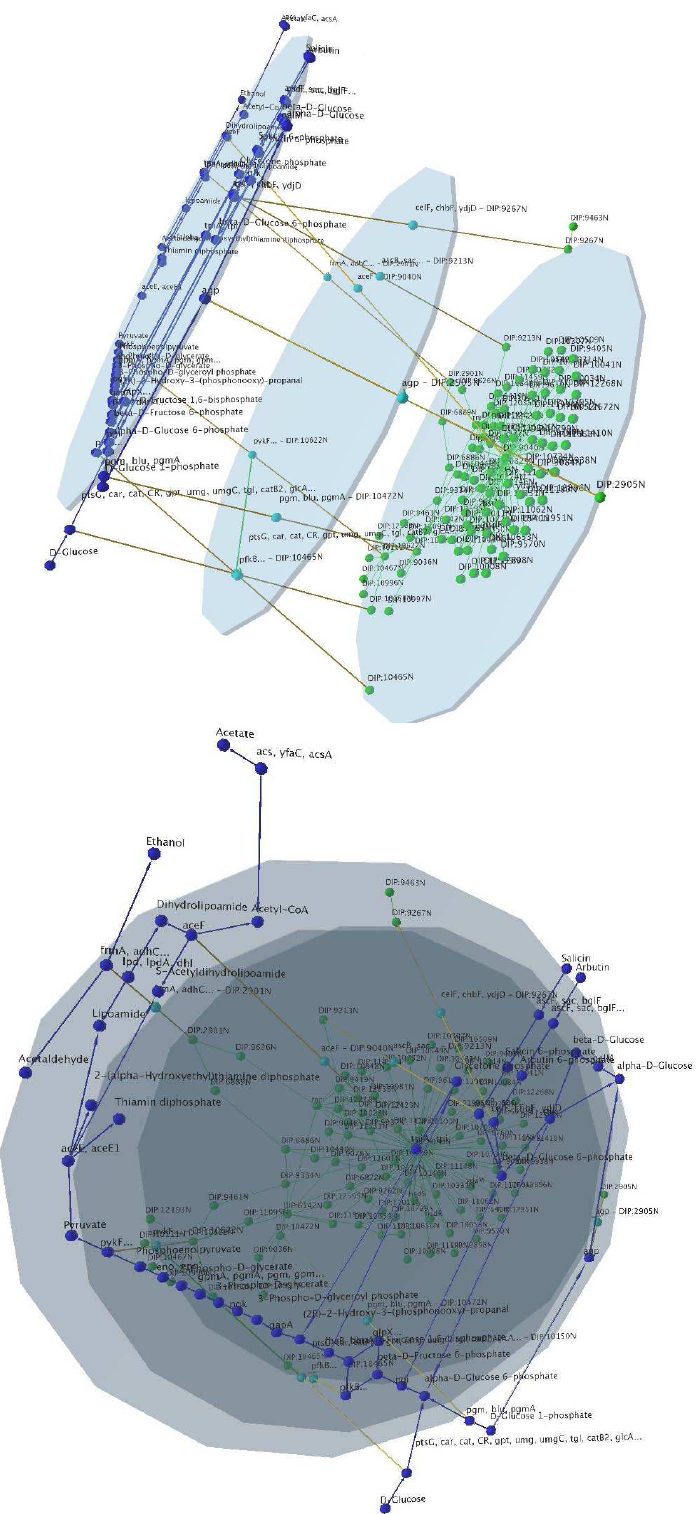
Figure 2: Visualisation (side and top view) of the two overlapping networks representing a metabolic network (glycolysis) and a corresponding part of a protein interaction network. The given layout of the metabolic pathway, nodes in blue, is clearly visible. The protein interaction network and inter-plane edges are drawn with a variation of a force directed